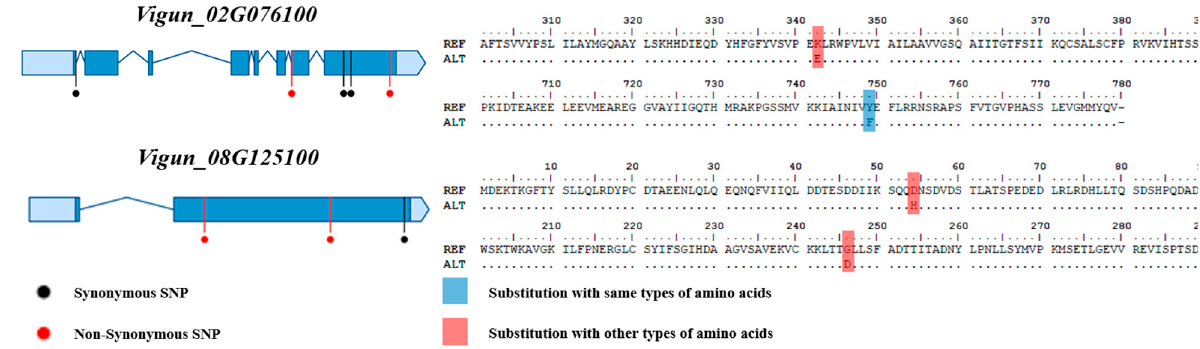
Figure 6. Gene model and variation information of two candidate genes related to salt-stress.